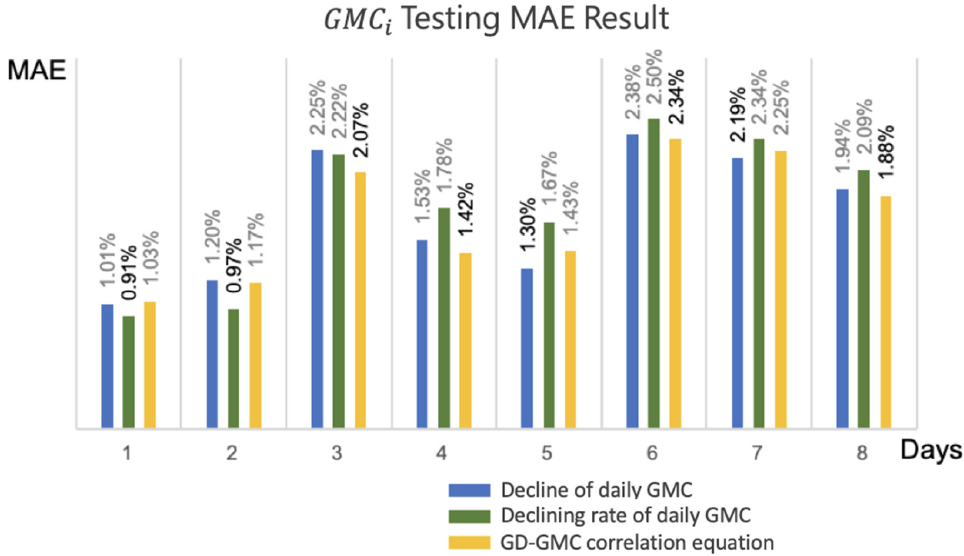
Figure 19. Multi-day testing data for (cid:1833)(cid:1839)(cid:1829) (cid:3036) MAE evaluation.